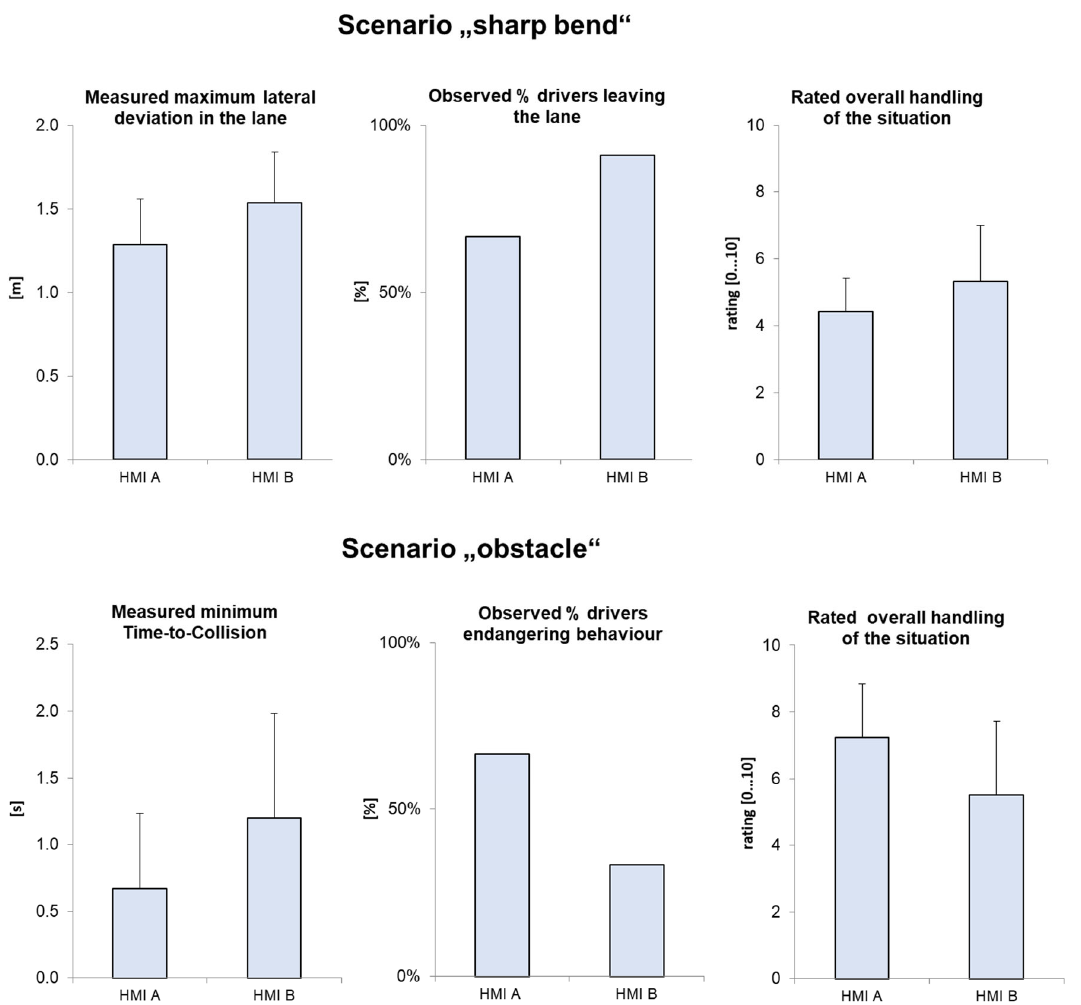
Figure 4. Comparison of measures for the two scenarios “sharp bend” ( above : maximum lateral lane deviation; observed % of drivers leaving the lane; overall handling of the situation) and “obstacle” ( below : minimum time-to-collision; observed % drivers showing endangering behavior; overall handling of the situation).